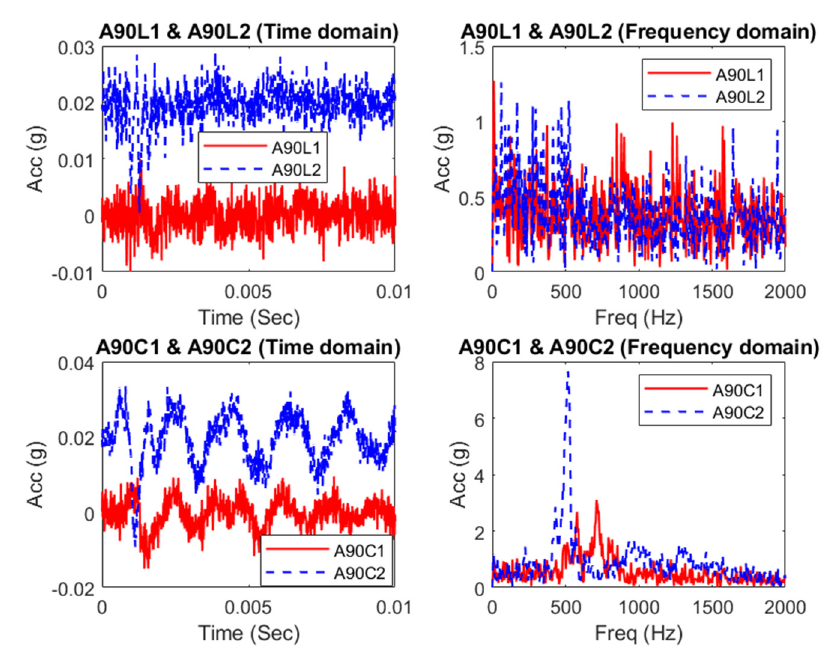
Figure 11. Captured time domain acceleration data and their frequency spectra at 90° position.